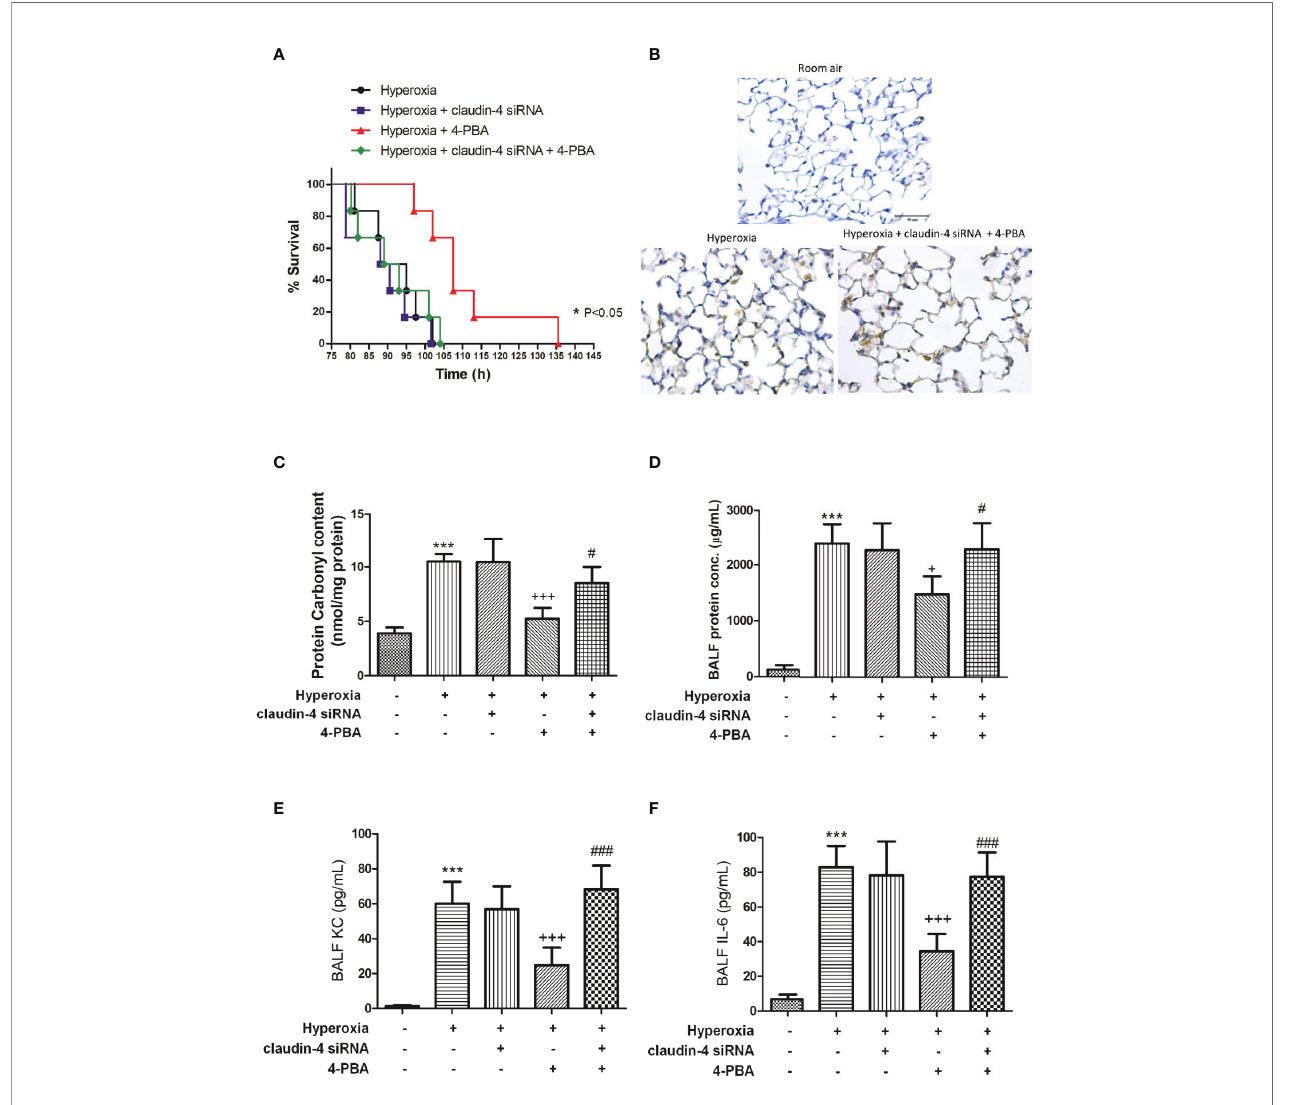
FIGURE 9 | The bene fi cial effects of 4-PBA in mice with hyperoxia-induced lung injury were abolished by claudin-4 siRNA. Survival for each group was monitored during the observation period and plotted as Kaplan-Meier survival curves. The difference in survival between hyperoxia + 4-PBA and hyperoxia + claudin-4 siRNA + 4-PBA groups was signi fi cant (p < 0.05, log-rank test) (A) . Representative immunohistochemical staining images of MPO (B) . Protein carbonyl contents (C) in lung tissue and protein (D) , KC (E) , and IL-6 (F) levels in the BALF were measured by ELISA. The results are expressed as the mean ± SD; n=6. ***p < 0.001, compared with the control group; + p < 0.05, +++ p < 0.001 compared with the hyperoxia group. # p < 0.05, ### p < 0.001 compared with the hyperoxia + 4-PBA